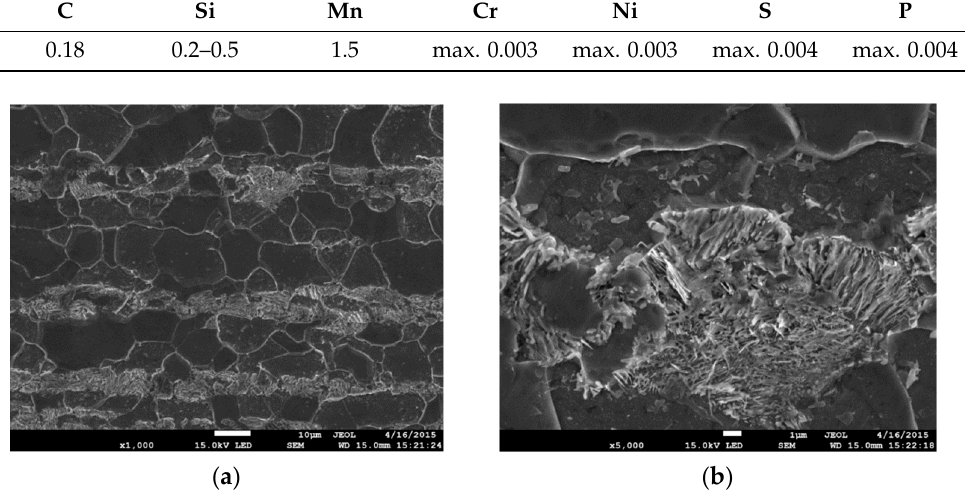
Figure 1. Steel S355 of ferrite-perlite ( FP ) microstructure: ( a ) ×1000; ( b )